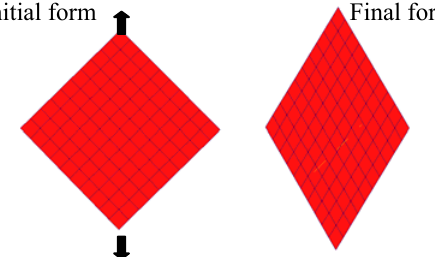
Fi g 4: Simulation of picture frame